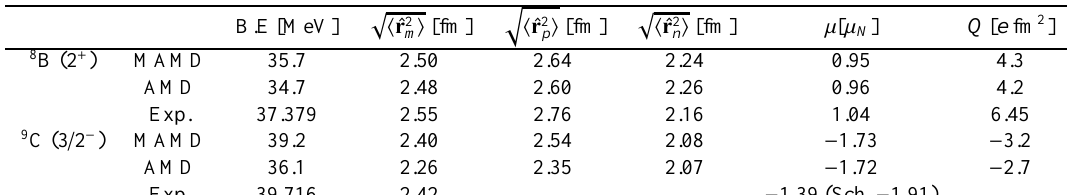
Table 1. Energy, radii, magnetic dipole and electric quadrupole moments of 8 B and 9 C. The empirical values of the radii are taken from Ref. [20] for 8 B, and Ref. [21] for 9 C. The Schmidt value of the magnetic dipole moment of 9 C is shown in parentheses.